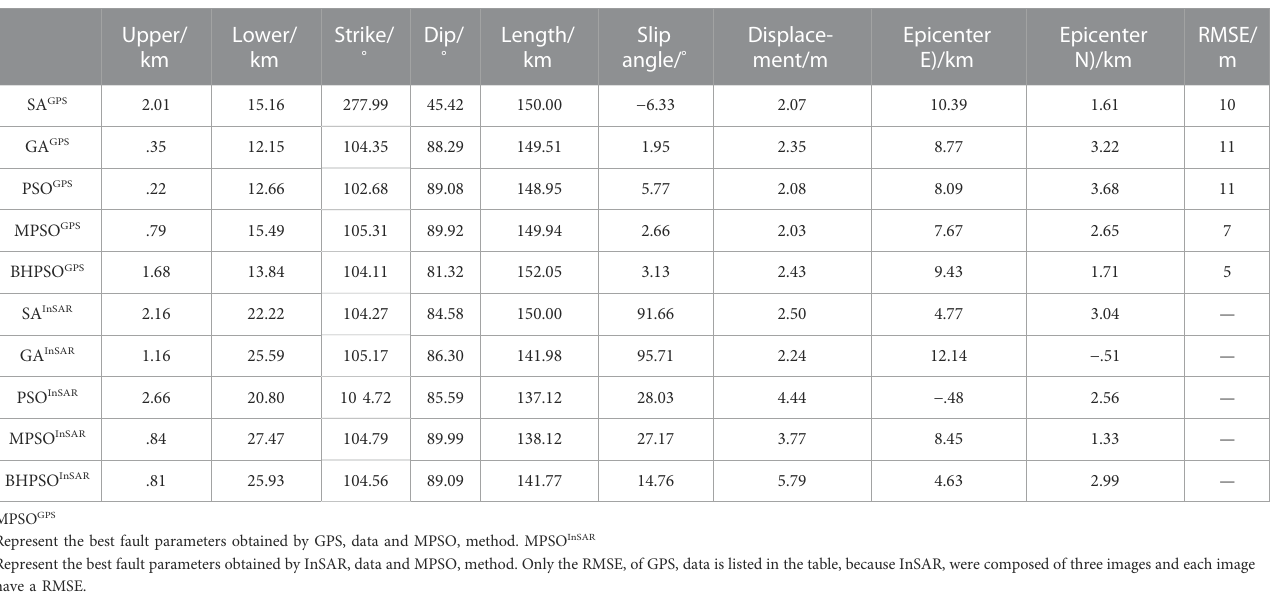
TABLE 7 The inversion results of fault parameters for the Maduo earthquake.